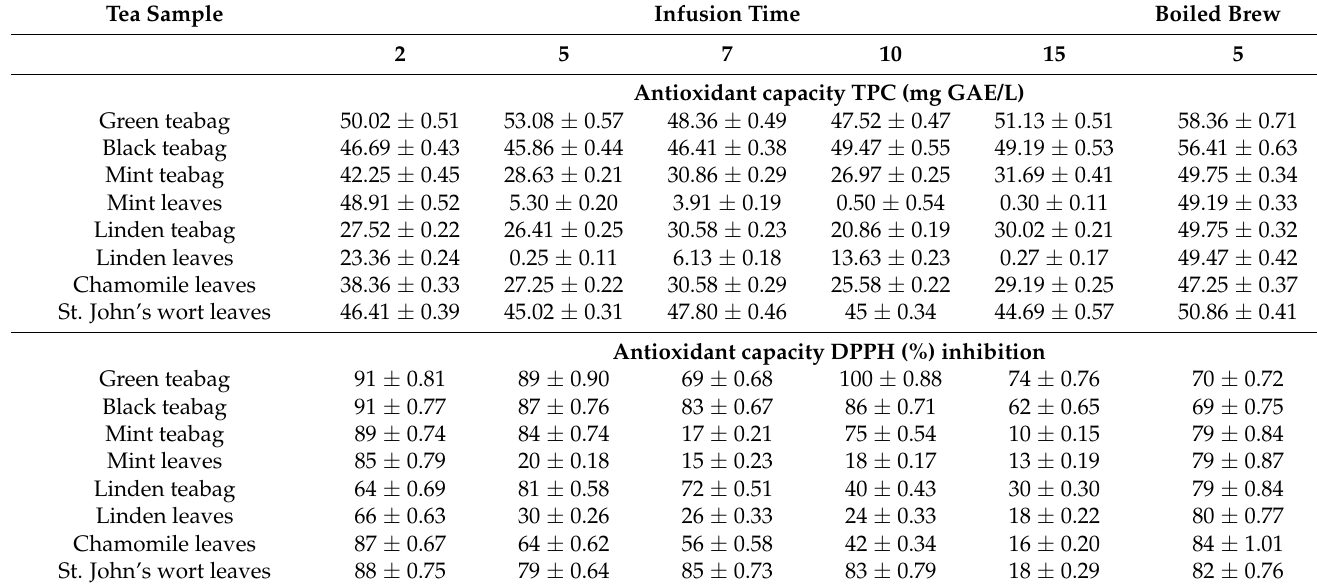
Table 2. Evolution of antioxidant capacity and total phenolic compounds content ( x ± SD ) of tea plant infusions. Tea Sample